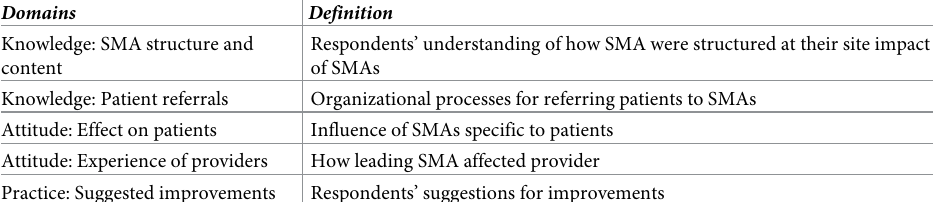
Table 2. Matrix domains and operational